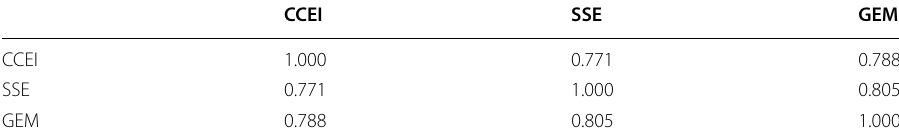
Table 6 Spearman rank correlation between explanatory